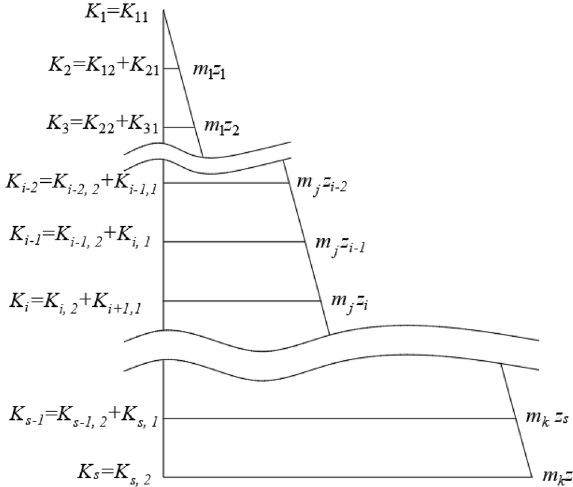
Figure 3. Schematic diagram of spring stiffness